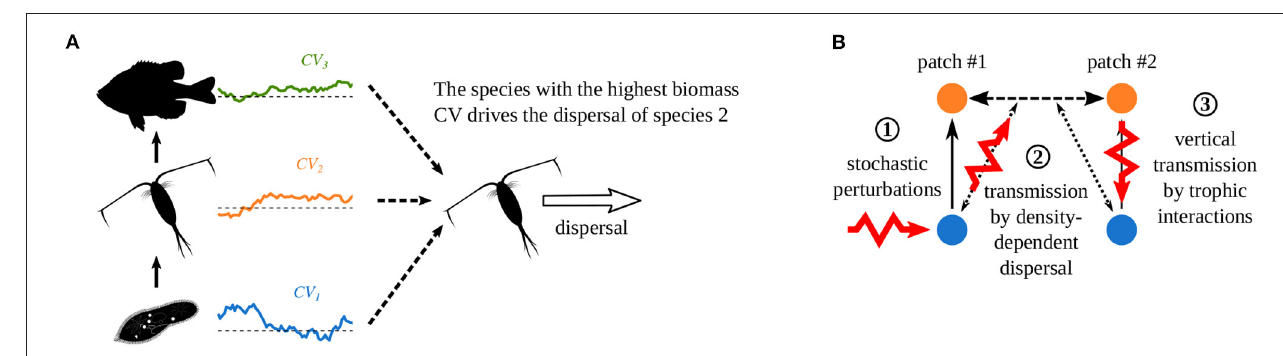
FIGURE 5 | Effect of density-dependent dispersal on perturbation propagation in metacommunities. (A) If dispersal depends on the density of several species, the species with the highest biomass CV drives dispersal. (B) Propagation of stochastic perturbations when predators have prey density-dependent dispersal. 1 Direct stochastic perturbation of prey in patch #1. 2 Horizontal transmission to the predators in patch #2 by density-dependent dispersal that bypasses vertical transmission in patch #1. 3 Vertical transmission in patch #2 through trophic interactions. (Adapted from Quévreux et al., 2021c).